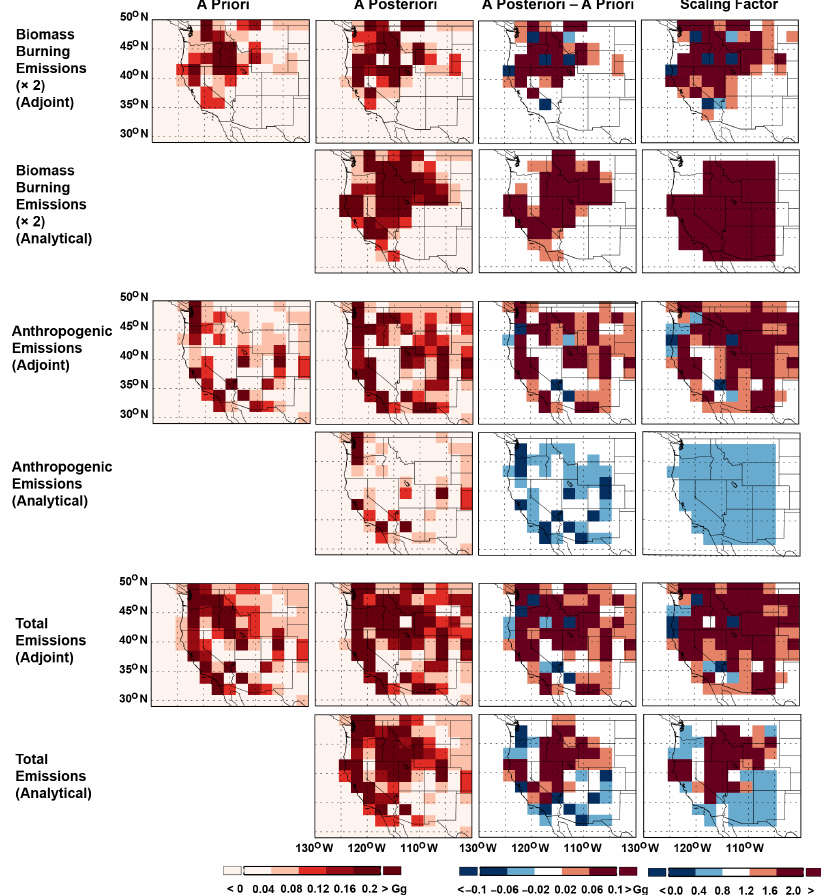
Figure 2. Emissions of BC in the WUS for August 2006: (top two rows) biomass burning, (middle two rows) anthropogenic, and (bottom two rows) total emissions. First column – the a priori; second column – the optimized inventory; third column – differences between the a posteriori and a priori; fourth column – scaling factors. For the purpose of clarity, biomass burning emissions are multiplied by 2 in the figures. Retrieval results are from the standard adjoint (Case 1, Table 1) and analytical (Mao et al., 2014) inversions at 2 ◦ × 2.5 ◦ . We assume for inversions uncertainties of 500, 50, and 30% for biomass burning BC emissions, anthropogenic BC emissions, and total observation